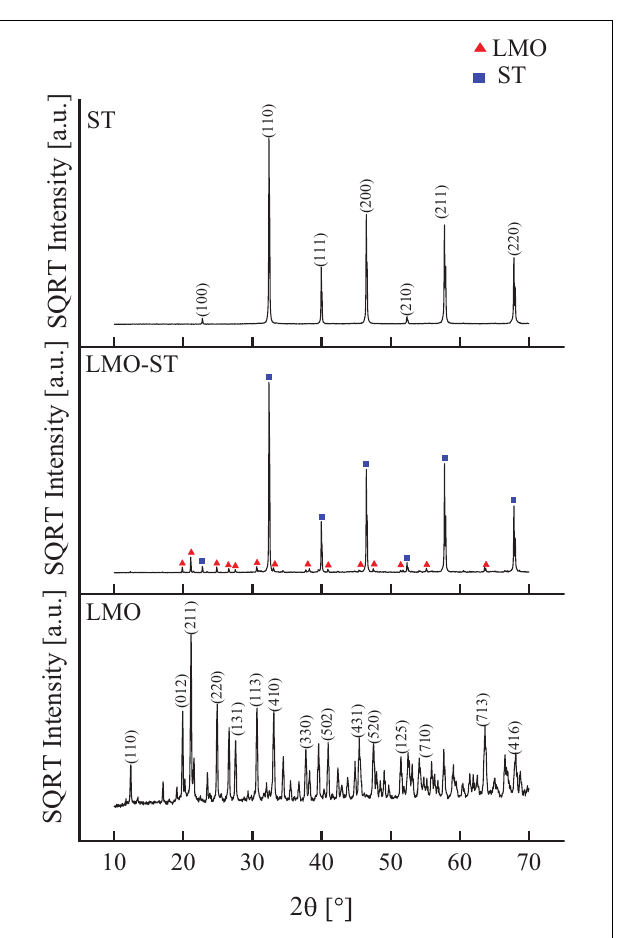
FIGURE 3 | X-ray diffraction patterns of LMO-ST composite, ST sintered at 1,400 ◦ C and commercial